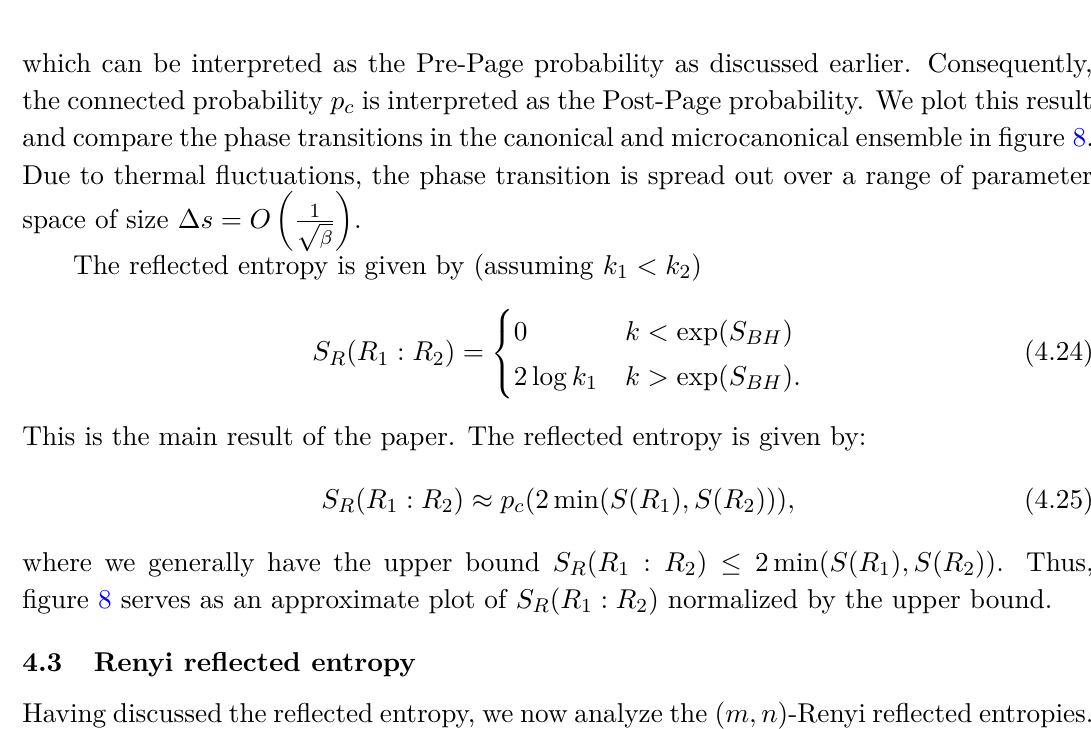
for m = 1 as a function of q = βs k , for β = 1 , in the 2min( S ( R 1 ) ,S ( R 2 )) 2 π (cid:18) (cid:19) 1 √ due to thermal β